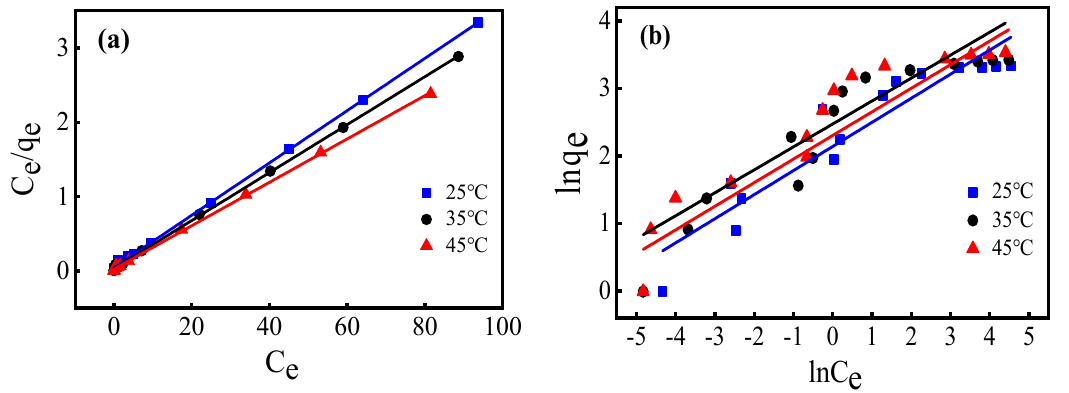
Figure 6. Isotherm plots for Cr(VI) adsorption onto FM-MBC. ( a ) Langmuir equation, ( b ) Freundlich equation. Table 2. Isotherm parameters for Cr(VI) adsorption onto the FM-MBC. Langmuir Equation Freundlich Temperature ◦ C